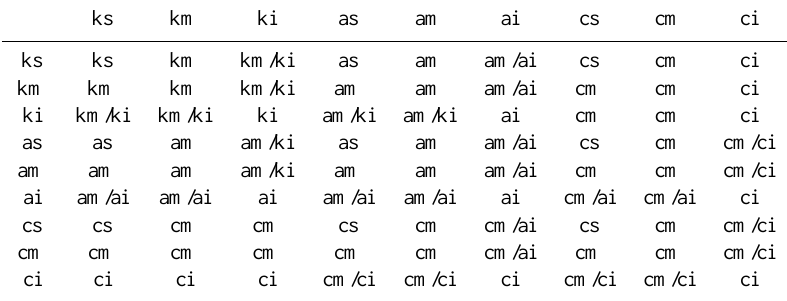
Table 2. Matrix elements τ lm (table cells) for assignment of particles that result from coagulation of particles from mode l (row) with particles from mode m (column). The mode naming convention is “k”, “a”, “c” as a first letter to specify the Aitken, accumulation, or coarse mode, respectively, and “s”, “m”, “i” as a second letter for the soluble, mixed, or insoluble mode, respectively. Thus, the soluble coarse mode, for instance, is named “cs”. Corresponding numbers are as follows: ks = 1, km = 2, ki = 3, as = 4, am = 5, ai = 6, cs = 7, cm = 8, and ci =